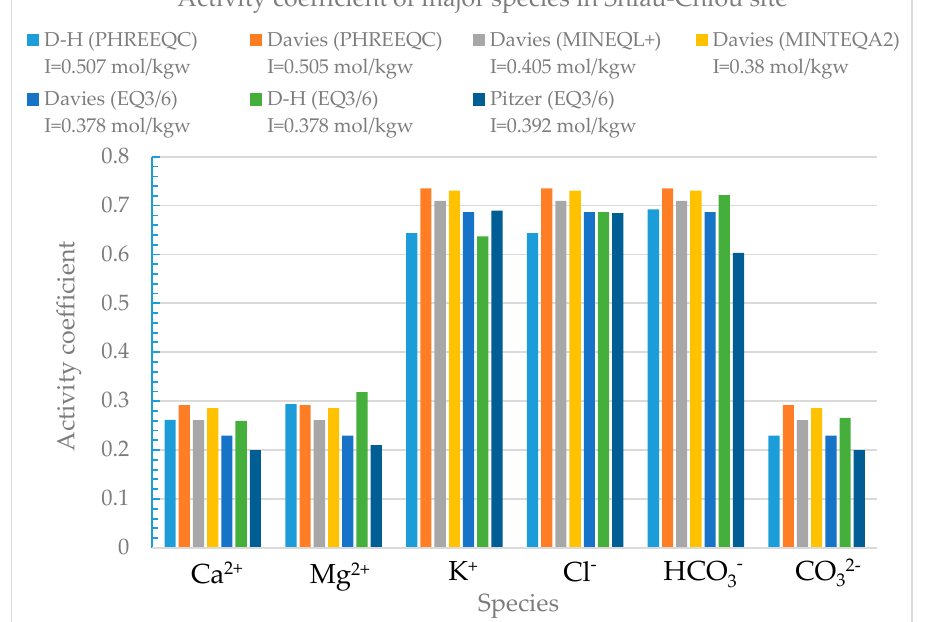
Figure 18. Activity coefficients of the major species for the four models with different activity coefficient equations at the Shiau-Chiou site.